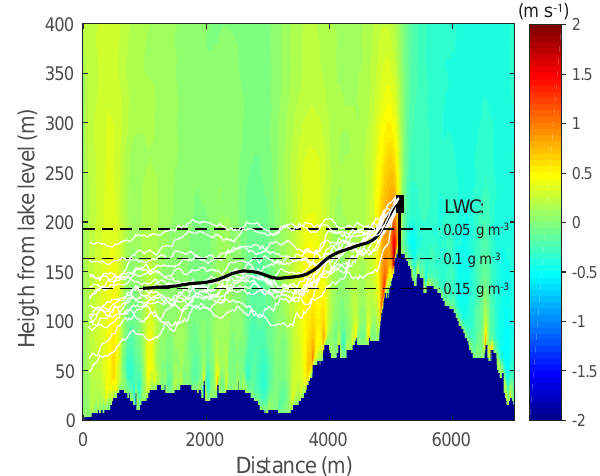
Figure 4. Simulated average wind fields and example trajectories (white curves) of air parcels. The black line depicts the average over all simulated